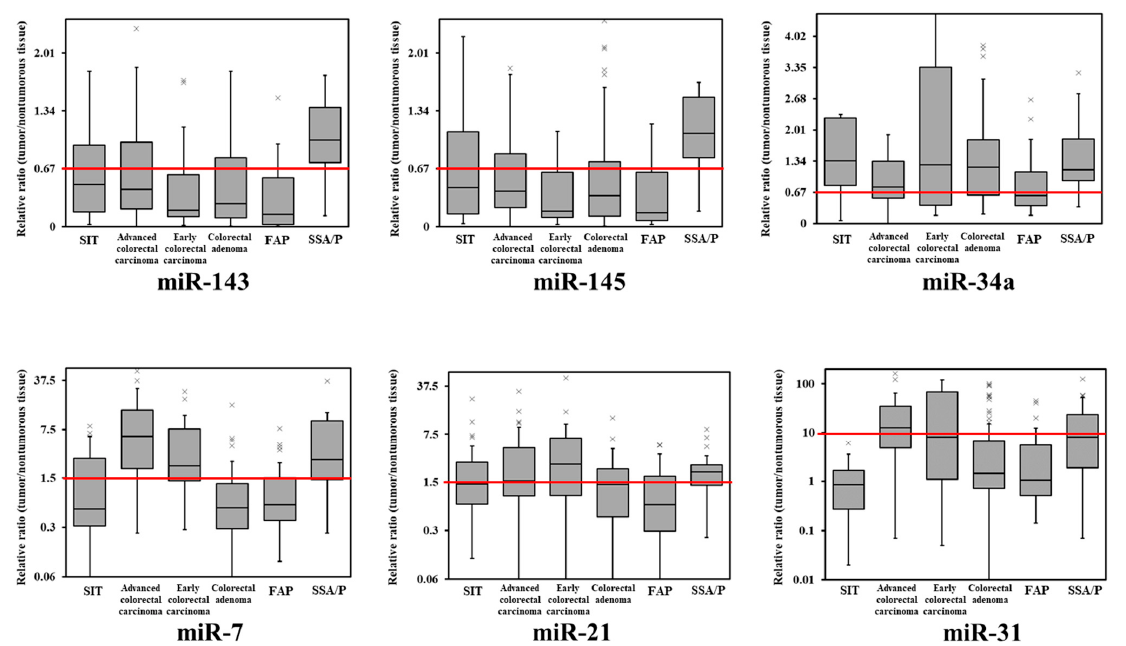
Figure 1. Box-and-whisker plots of miR-143, miR-145, miR-7, miR-21, miR-34a, and miR-31 expression in small intestinal tumors and colorectal tumors. The relative expression level in normal tissue was defined as 1. SIT, small intestinal tumor (adenoma and adenocarcinoma); FAP, familial adenomatous polyposis; SSA/P, sessile serrated adenoma/polyp; × , upper outlier (over the 3rd quartile + 1.5 × interquartile range).